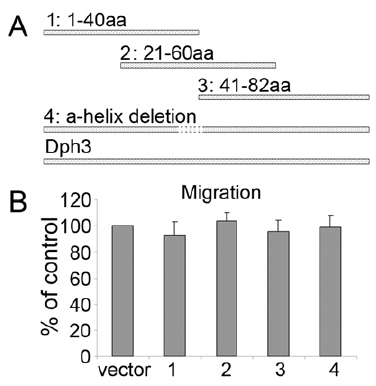
Figure 4. Full length of Dph3 was required for the metastasis of murine melanoma B16F10 cells. A, Schematic presentation of a mutant with a predicted 6 amino acids helix deletion between 36–41 of the whole protein sequence and 3 truncated mutants of Dph3. B, the cell motility was evaluated by transwell assays after transfection with different mutants.